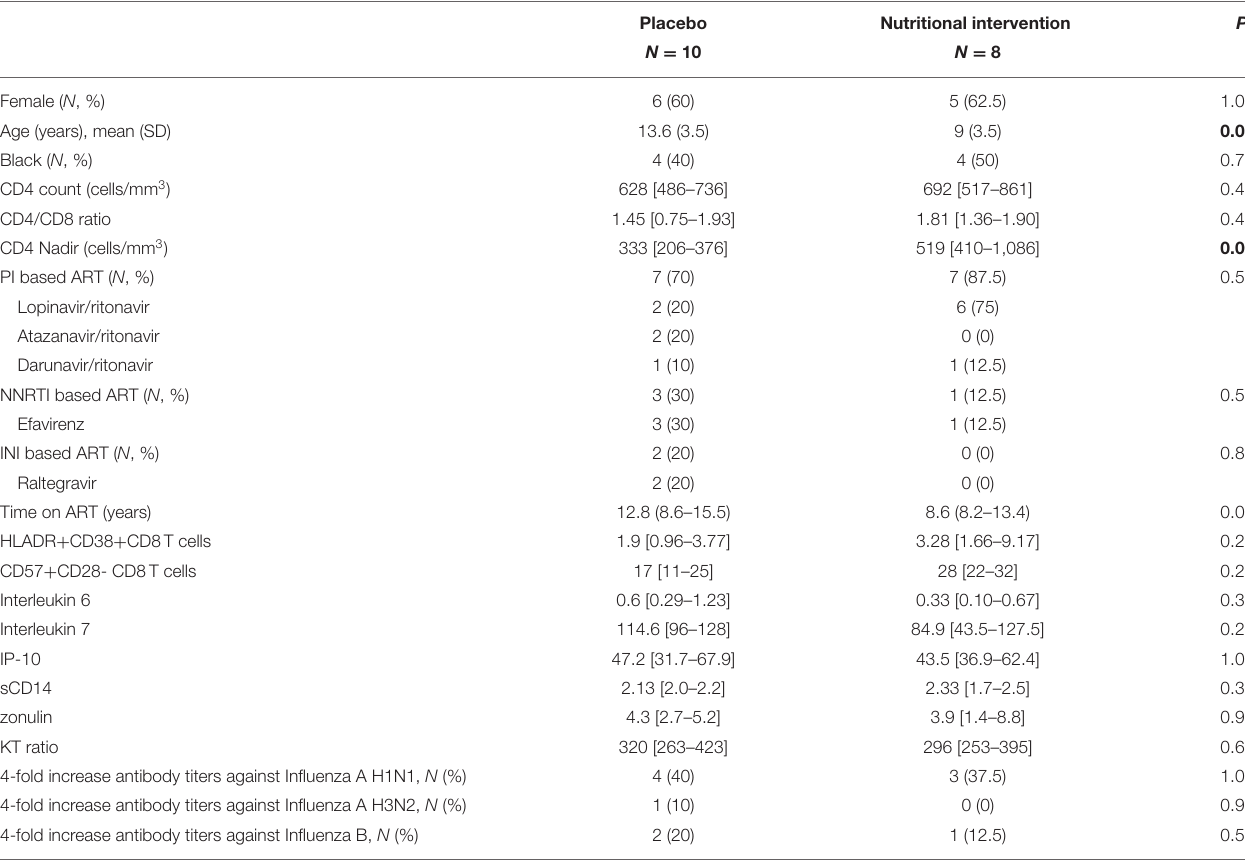
TABLE 1 | Clinical characteristics and laboratory parameters of study